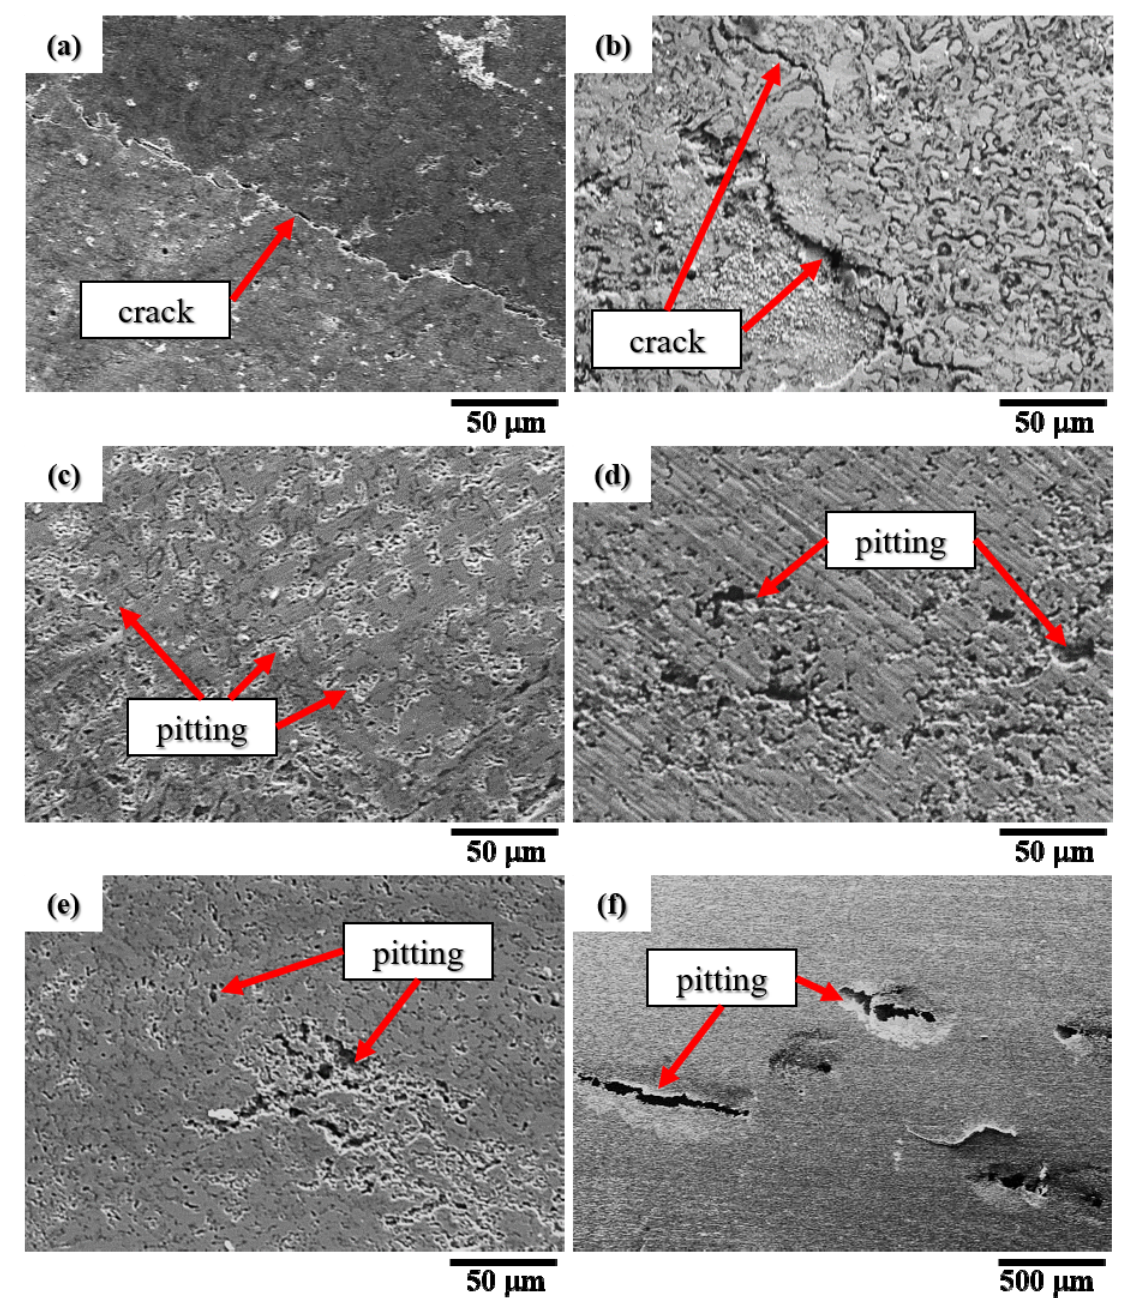
Figure 9. SEI surface morphologies of the CuFeTiZrNi x alloys after the polarization test in 3.5 wt.% NaCl solution: ( a ) x = 0.1, ( b ) x = 0.3, ( c ) x = 0.5, ( d ) x = 0.8, ( e ) x = 1.0, and ( f ) SUS 304.